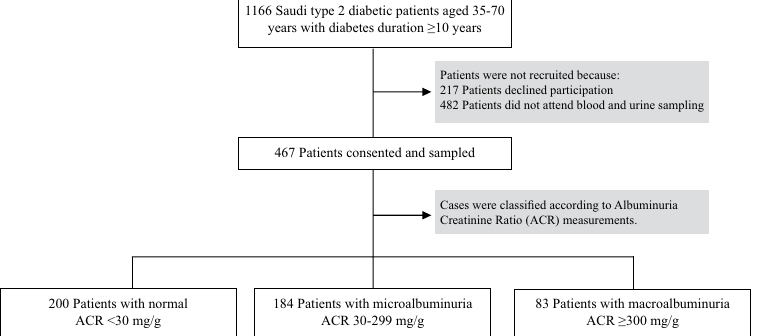
Figure 2. Study flow chart for case selection and